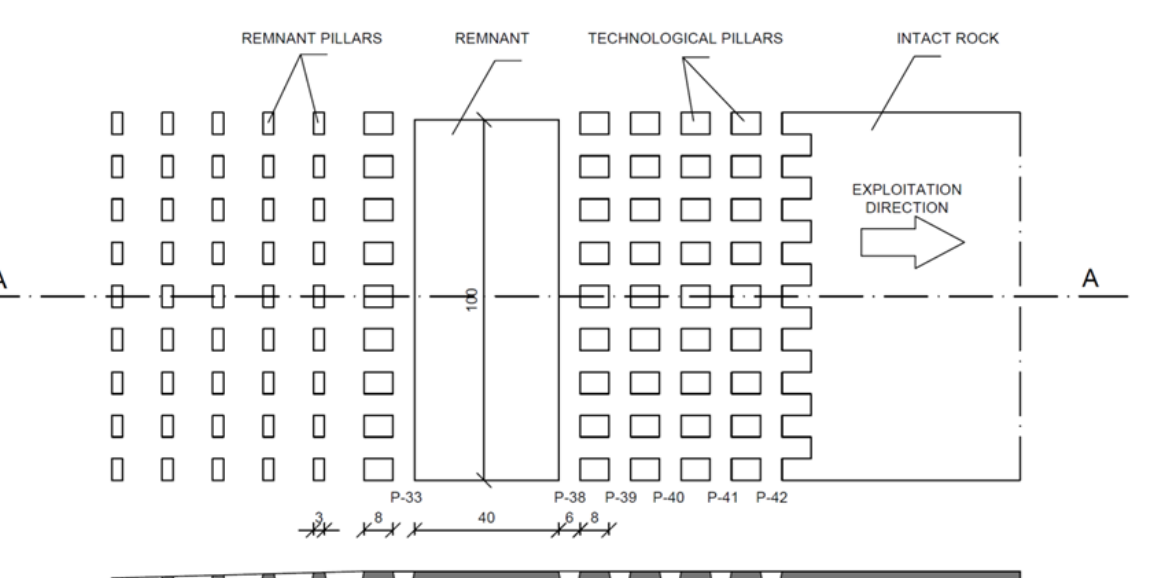
Figure 2. Analyzed mining field (room and pillar mining with roof deflection) and location of the 40 m wide remnant.